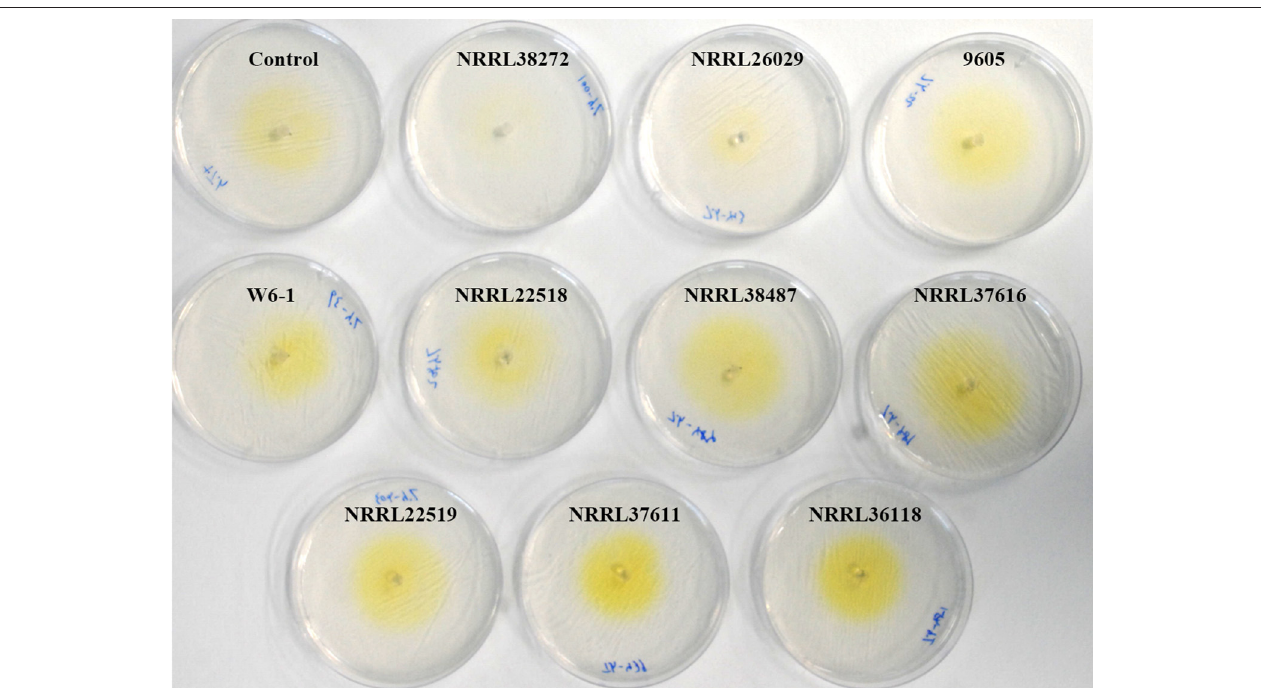
FIGURE 5 | Effect of F. oxysporum VCs on the secretion of yellow pigment by T. harzianum. T. harzianum strain T-22 cultured on cellophane membrane overlaid on PDA was co-cultivated with 10 F. oxysporum strains and un-inoculated PDA (Control) for 33h. After removing the cellophane membrane holding T-22 culture, plates were photographed (arranged based on the amount of pigment released).